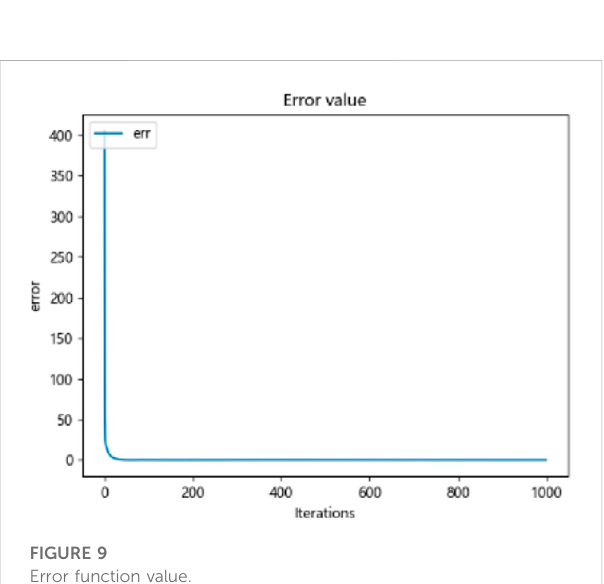
FIGURE 8 MAE values by using different optimizers.